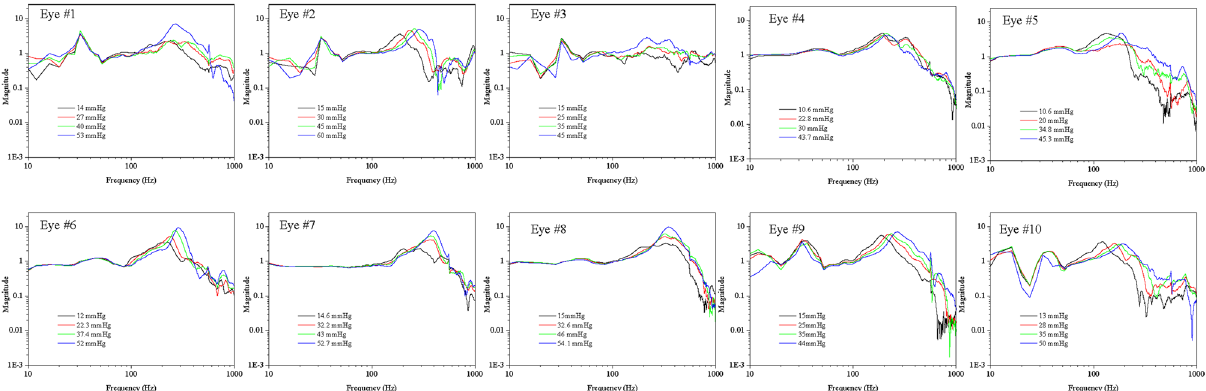
Figure 1. Transfer function according to increases in IOP Eye #1–#10.